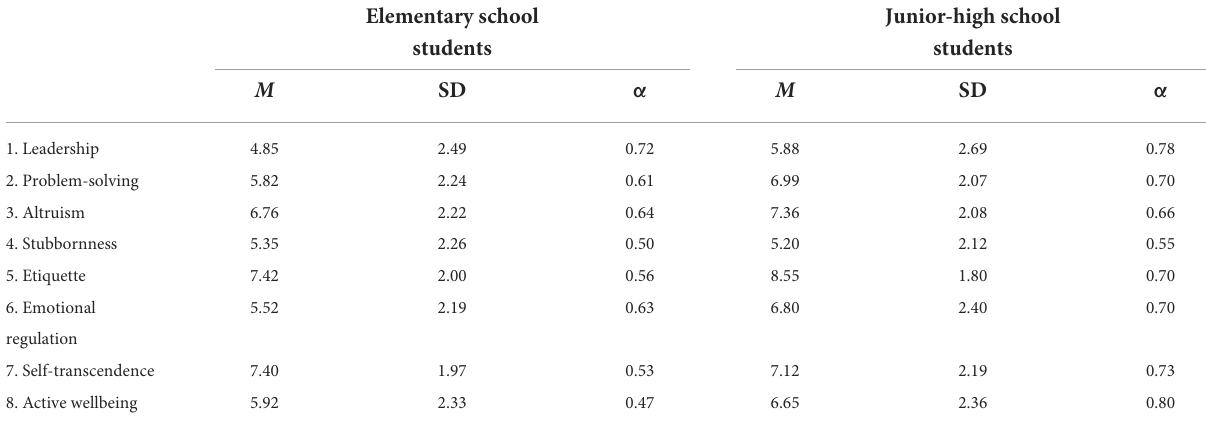
TABLE 5 Descriptive statistics and Cronbach’s alpha of the power to live questionnaire (16-item factor